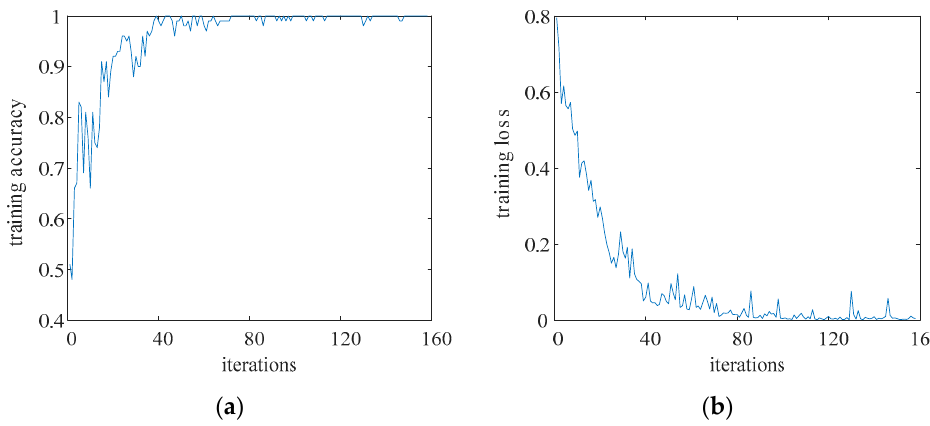
Figure 8. Training results of model. ( a ) Training accuracy; ( b ) Training loss.